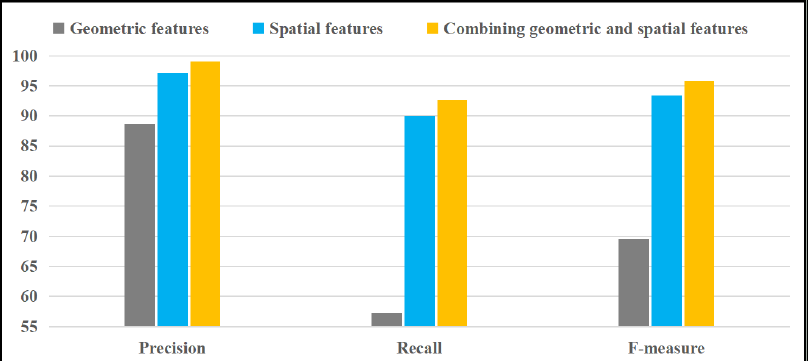
Figure 13. Performance c omparison of different feature matrixes.